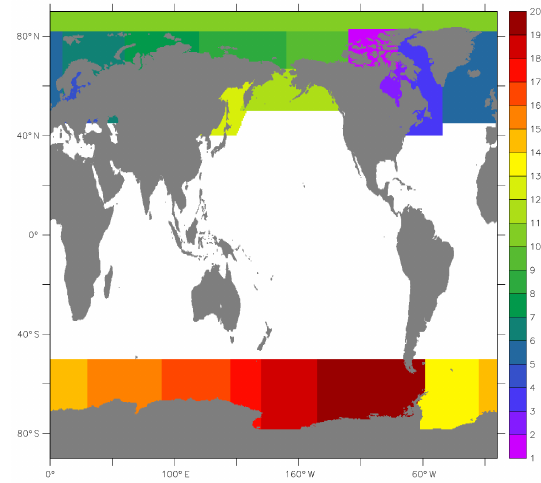
Figure B2. Geographical sectors used for the analogue method: (1) Canadian Archipelago, (2) Hudson Bay, (3) Baffin Bay and the Danish straits, (4) north-east Atlantic, (5) Baltic Sea, (6) Barents Sea, (7) Kara and White Sea, (8) Laptev and East Siberian Sea, (9) Beaufort Sea, (10) Arctic Basin, (11) Bering Sea, (12) Sea of Okhotsk, (13) Weddell Sea, (14) East Atlantic, (15) West Indian Ocean, (16) East Indian Ocean, (17) West Pacific, (18) Ross Sea, (19) Amundsen and Bellingshausen